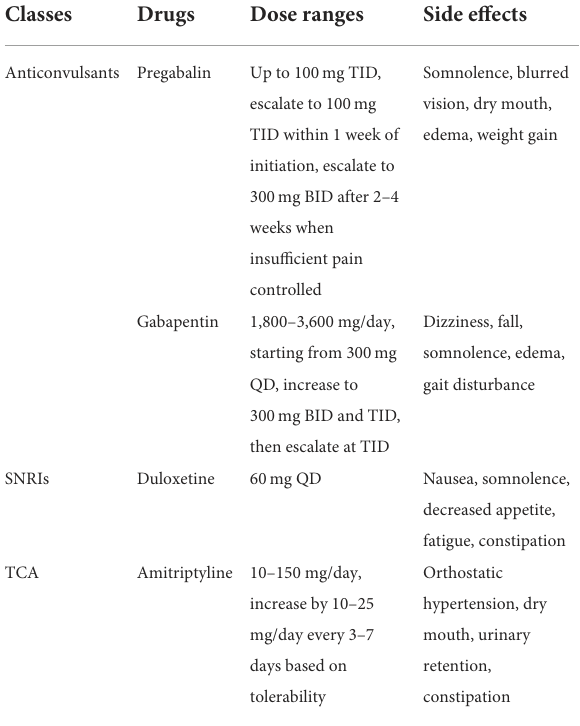
TABLE 3 Pharmacotherapies for painful